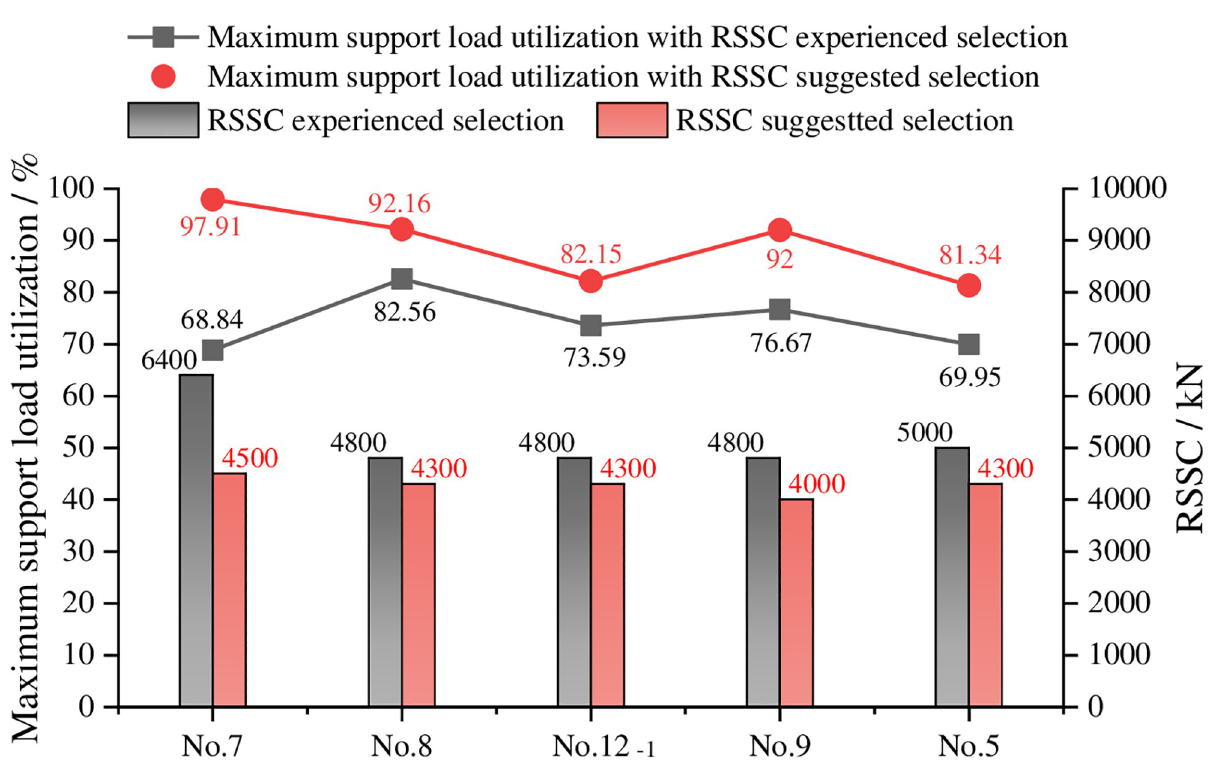
Fig 16. Compared results of the RSSC suggested and experienced